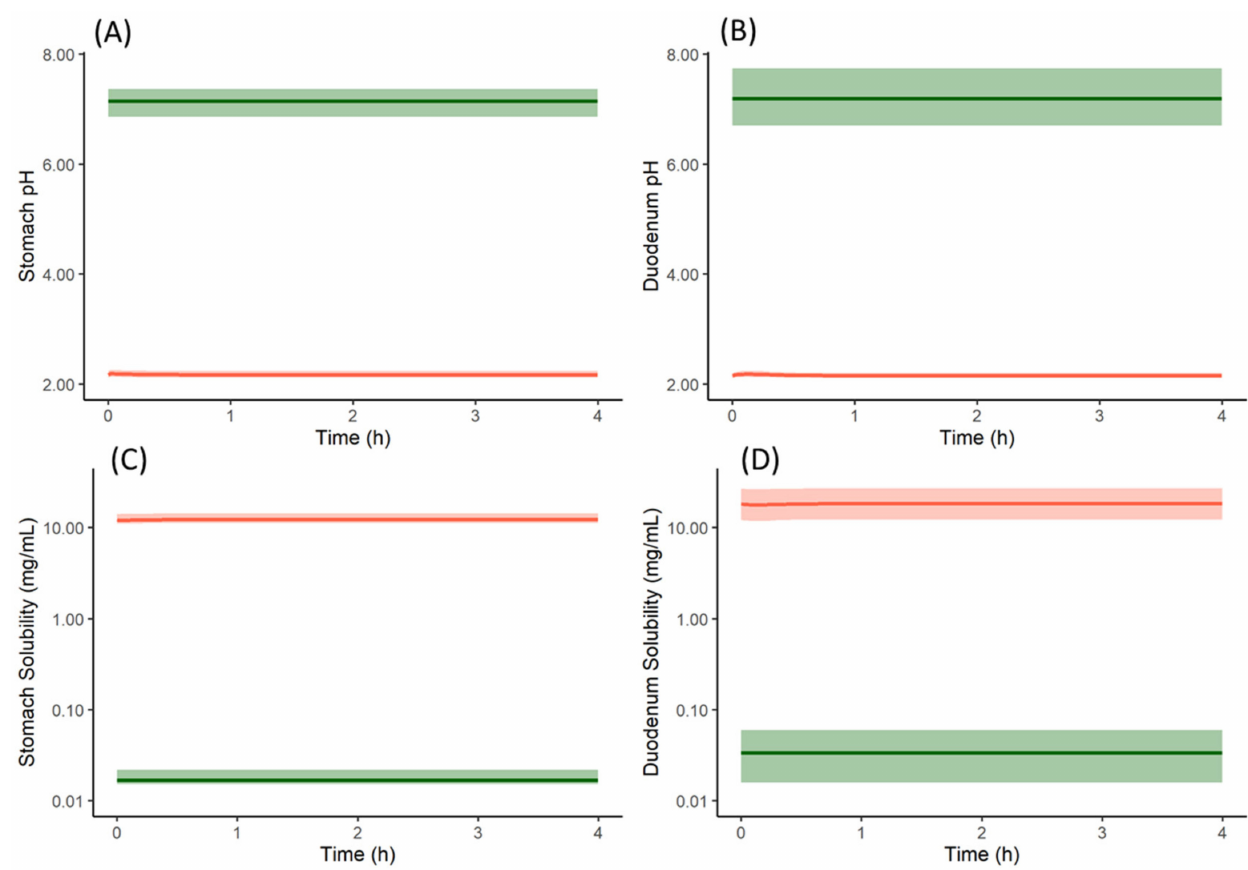
Figure 10. Particle surface pH (red in ( A , B )), bulk fluid pH (green in ( A , B )), particle surface solubility (red in ( C , D )) and bulk fluid solubility (green in ( C , D )) profiles of model compound salt form (Solid State 1) with famotidine in stomach ( A , C ) and duodenum ( B , D ). Solid lines represent mean and shaded area represent 5th and 95th percentiles of 100 simulated individual profiles. The profiles are only shown for stomach and duodenum compartments, similar results are obtained for the other intestinal